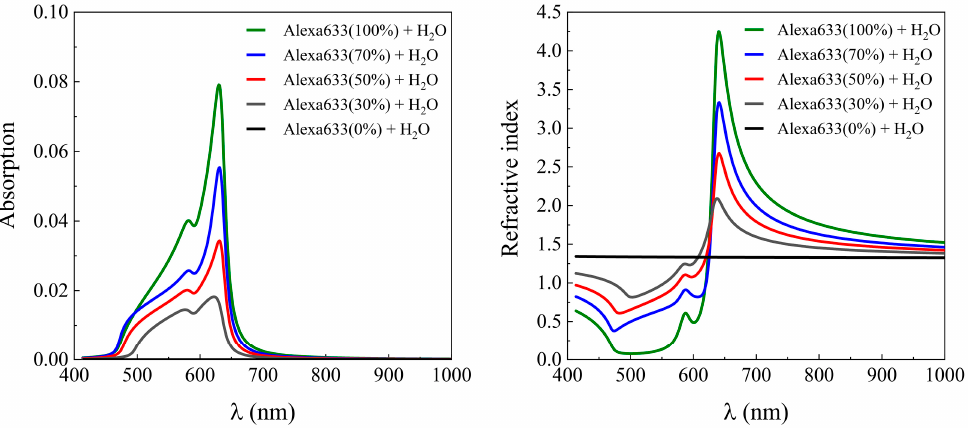
Figure 3. Absorption ( left ) coefficients and refractive index ( right ) of the HSA protein labeled with Alexa Fluor TM 633 dye.